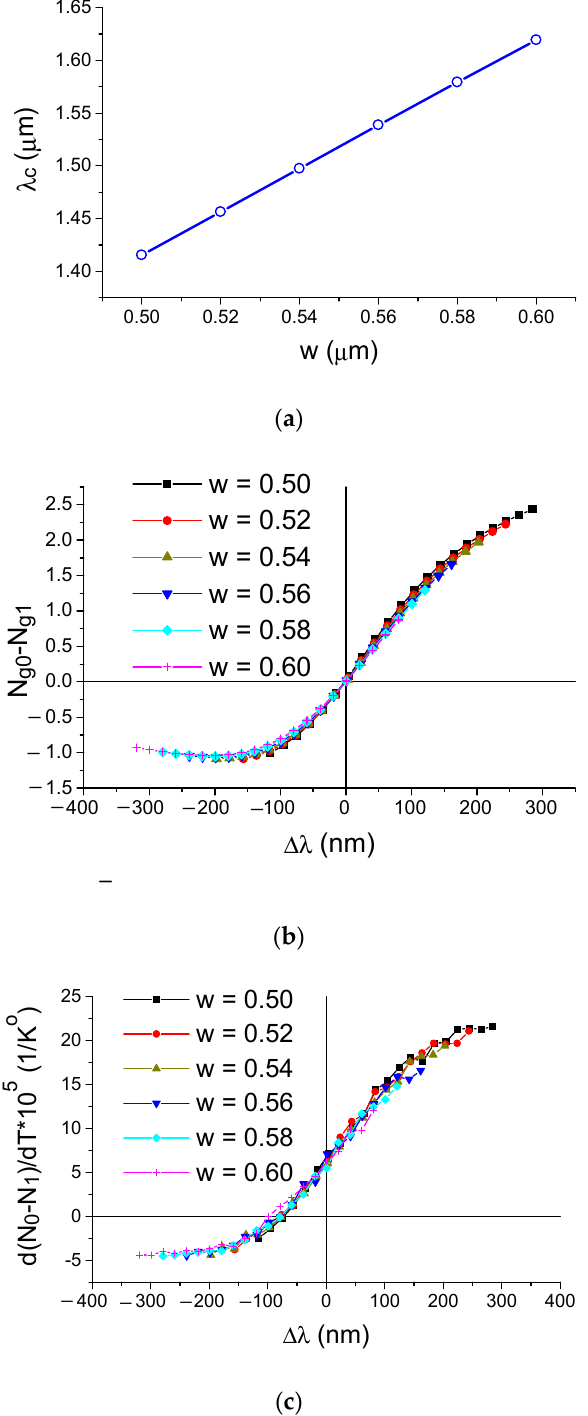
Figure 7. Critical parameters of the bimodal sensor. ( a ) Dependence of λ c on the waveguide width w. ( b ) Dependence of the difference for TE 0 and TE 1 group modes index on the cover index. ( c ) Dependence of the effective mode index temperature sensitivity on the optical wavelength increment ∆ λ = λ – λ c . Simulation by 3D